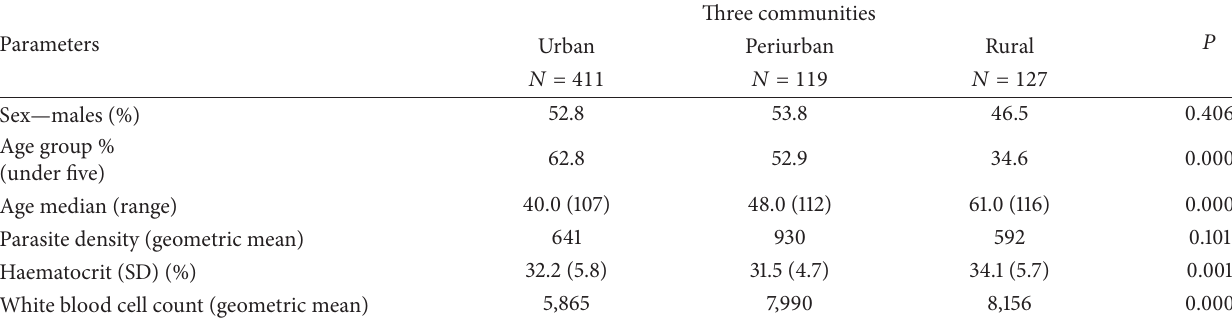
Table 1: Characteristics of asymptomatic carriers in three communities in Ibadan.